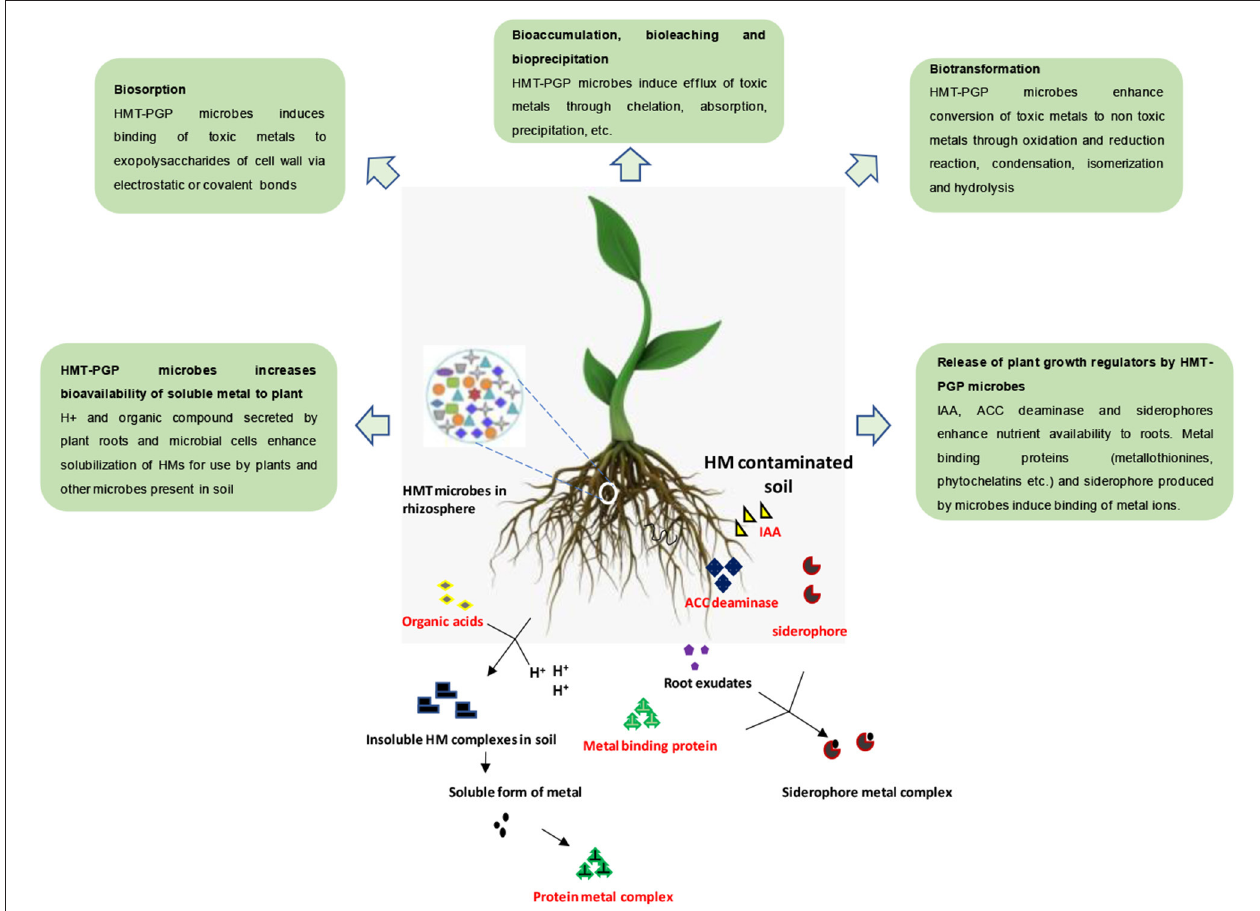
FIGURE 1 | Mechanism of action of HM-tolerant (HMT) microbiome in bioremediation of HM-contaminated soil. The HMT microbiota present in the rhizosphere may exhibit plant growth promoting traits including secretion of phytohormones, siderophores, etc. (Adapted from Mishra et al.,